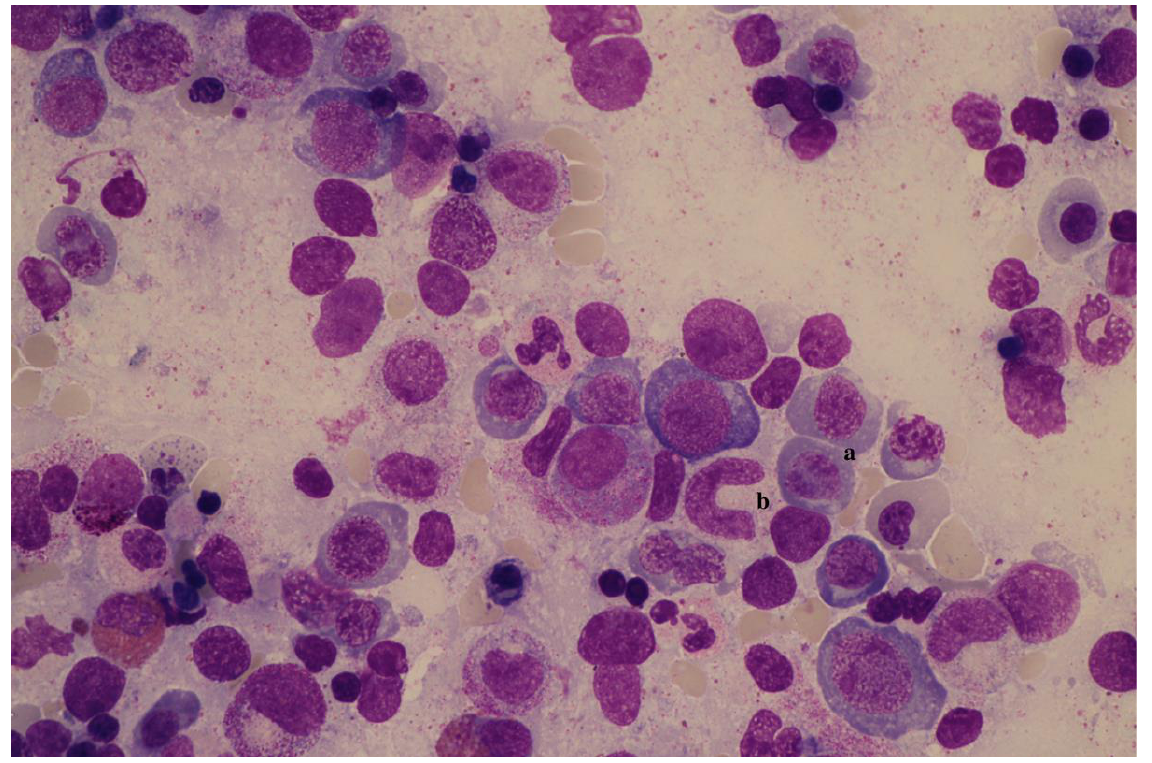
Figure 1. Myelogram. Erythroid hyperplasia with megaloblasts presenting asynchronism of nucleocytoplasmic maturation (a) and giant metamyelocyte (b).